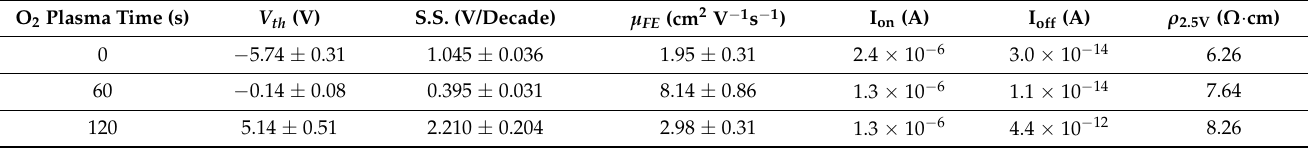
Figure 3. I DS - V GS transfer characteristics and I GS - V GS of IGZO TFTs with O 2 plasma times of 0, 60, and 120 s. Table 2. Electrical parameters extracted from the IGZO TFTs at various O 2 plasma times.